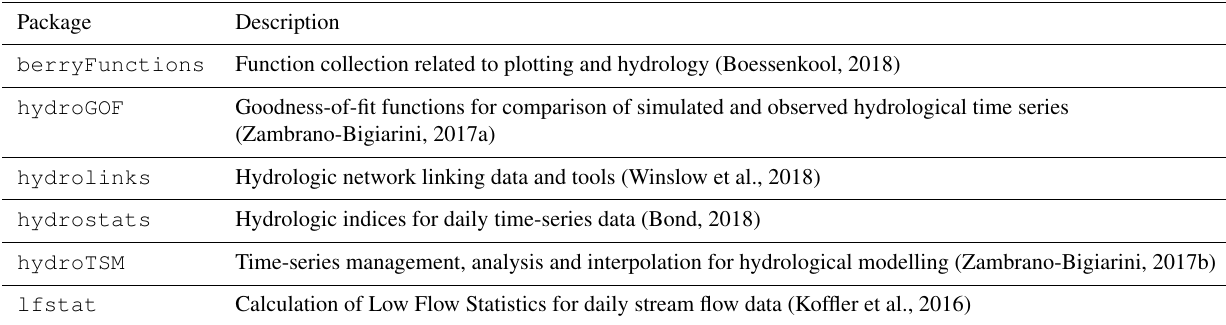
Table 3. Examples of packages for hydrological